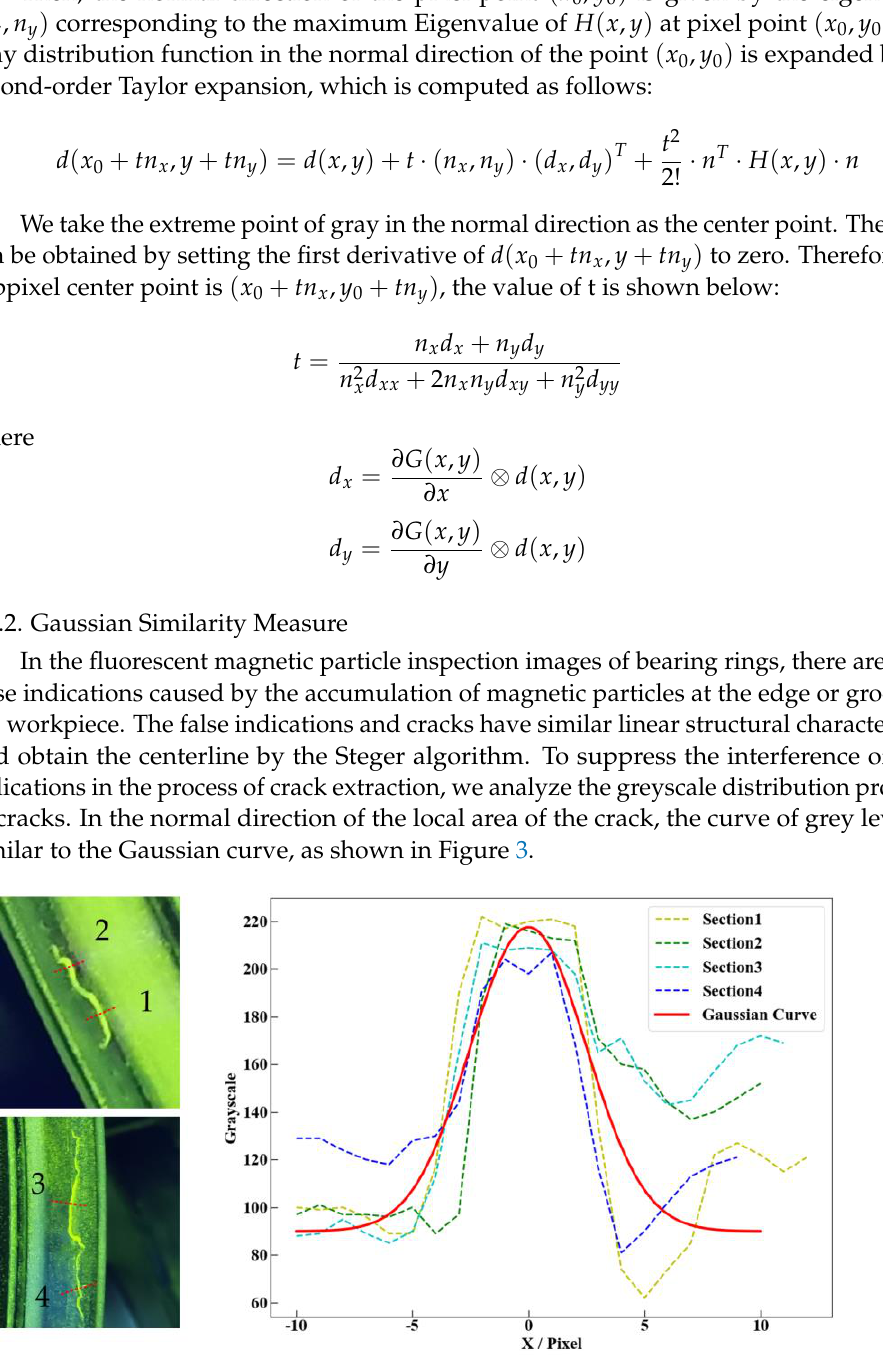
Figure 3. The greyscale distribution curves of crack defects in the normal direction.